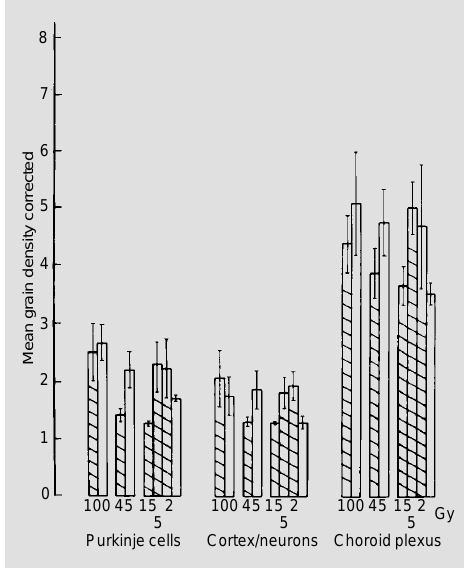
Figure 3 - Mean grain densities including standard error of the means (SEM; corrected for back- ground and [ 3 H]-ß-absorption) for the perikaryal cytoplasm of various cell types in the brain of the adult mouse after [ 3 H]-TdR injection plus 2-100 Gy X-irradia- tion of the head (hatched bars) or [ 3 H]-TdR injection and sham- irradiation (open